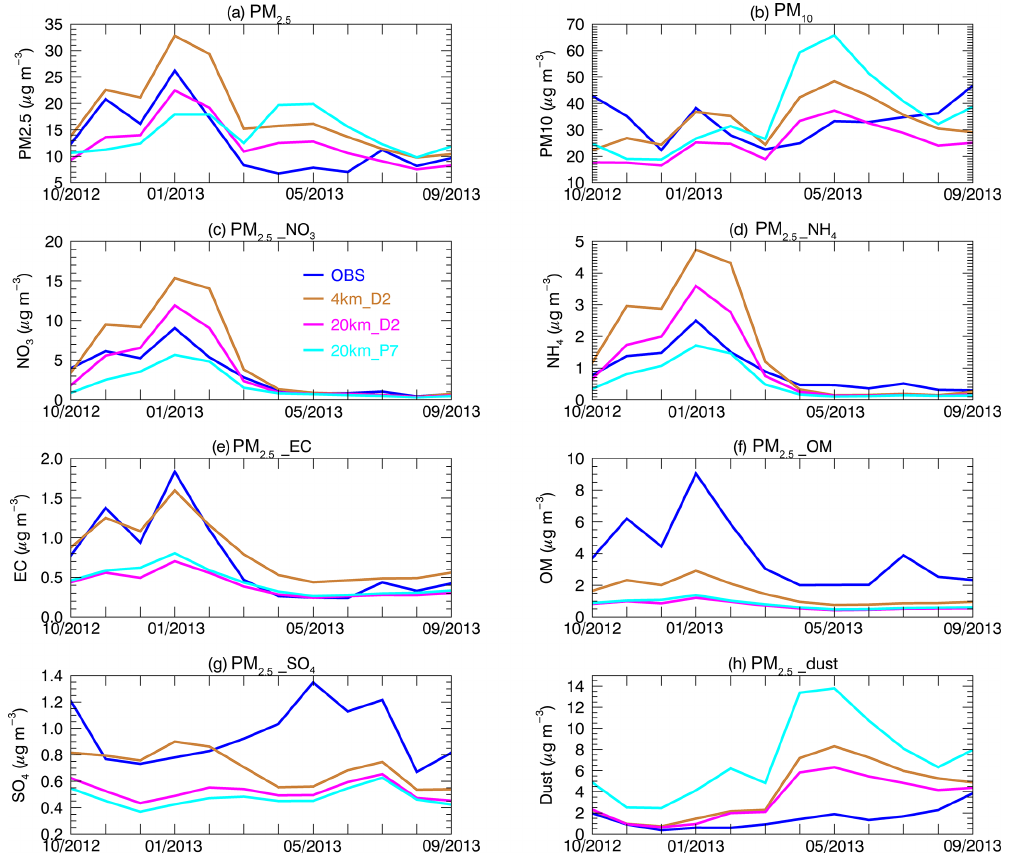
Figure 14. Aerosol mass (µgm − 3 ) for different species from OBS, the 4km_D2, 20km_D2 and 20km_P7 simulations at Fresno, CA. NH 4 observations are from the EPA; other observations are from IMPROVE. PM 2 . 5 _NO 3 represents NO 3 with a diameter ≤ 2.5µm. Similar definition for NH 4 , EC, OM, SO 4 and dust in the